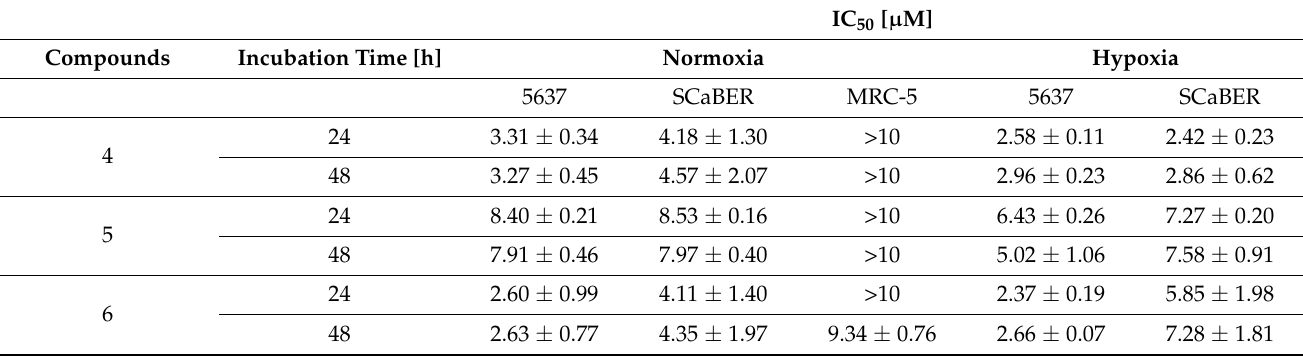
Table 1. The IC 50 values for tested compounds under normoxic and hypoxic conditions against 5637, SCaBER, and MRC-5 cells. Data presented as mean ± SD from at least two independent experiments. IC 50 [µM]